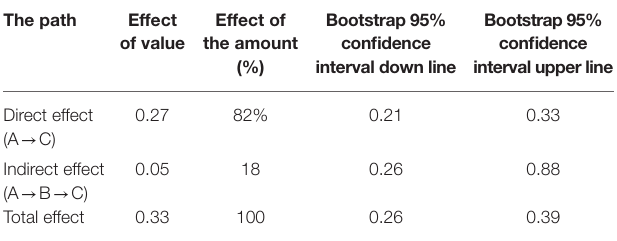
TABLE 4 | Bootstrap analysis of significance test of mediation effect ( n = 381).